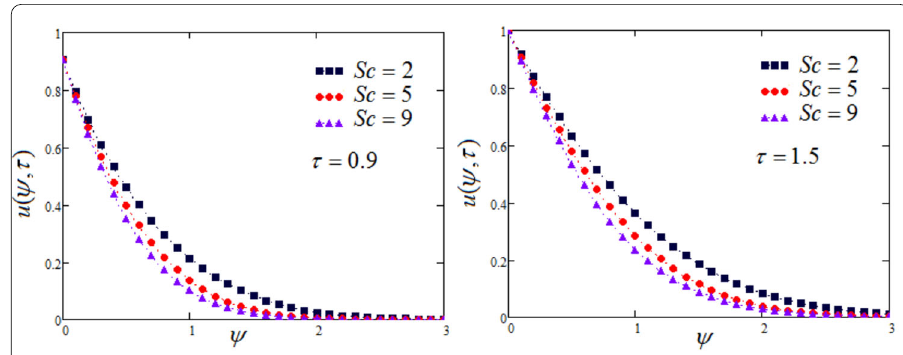
Figure 9 Velocity profiles of a Maxwell fluid for various values of Sc at two different times